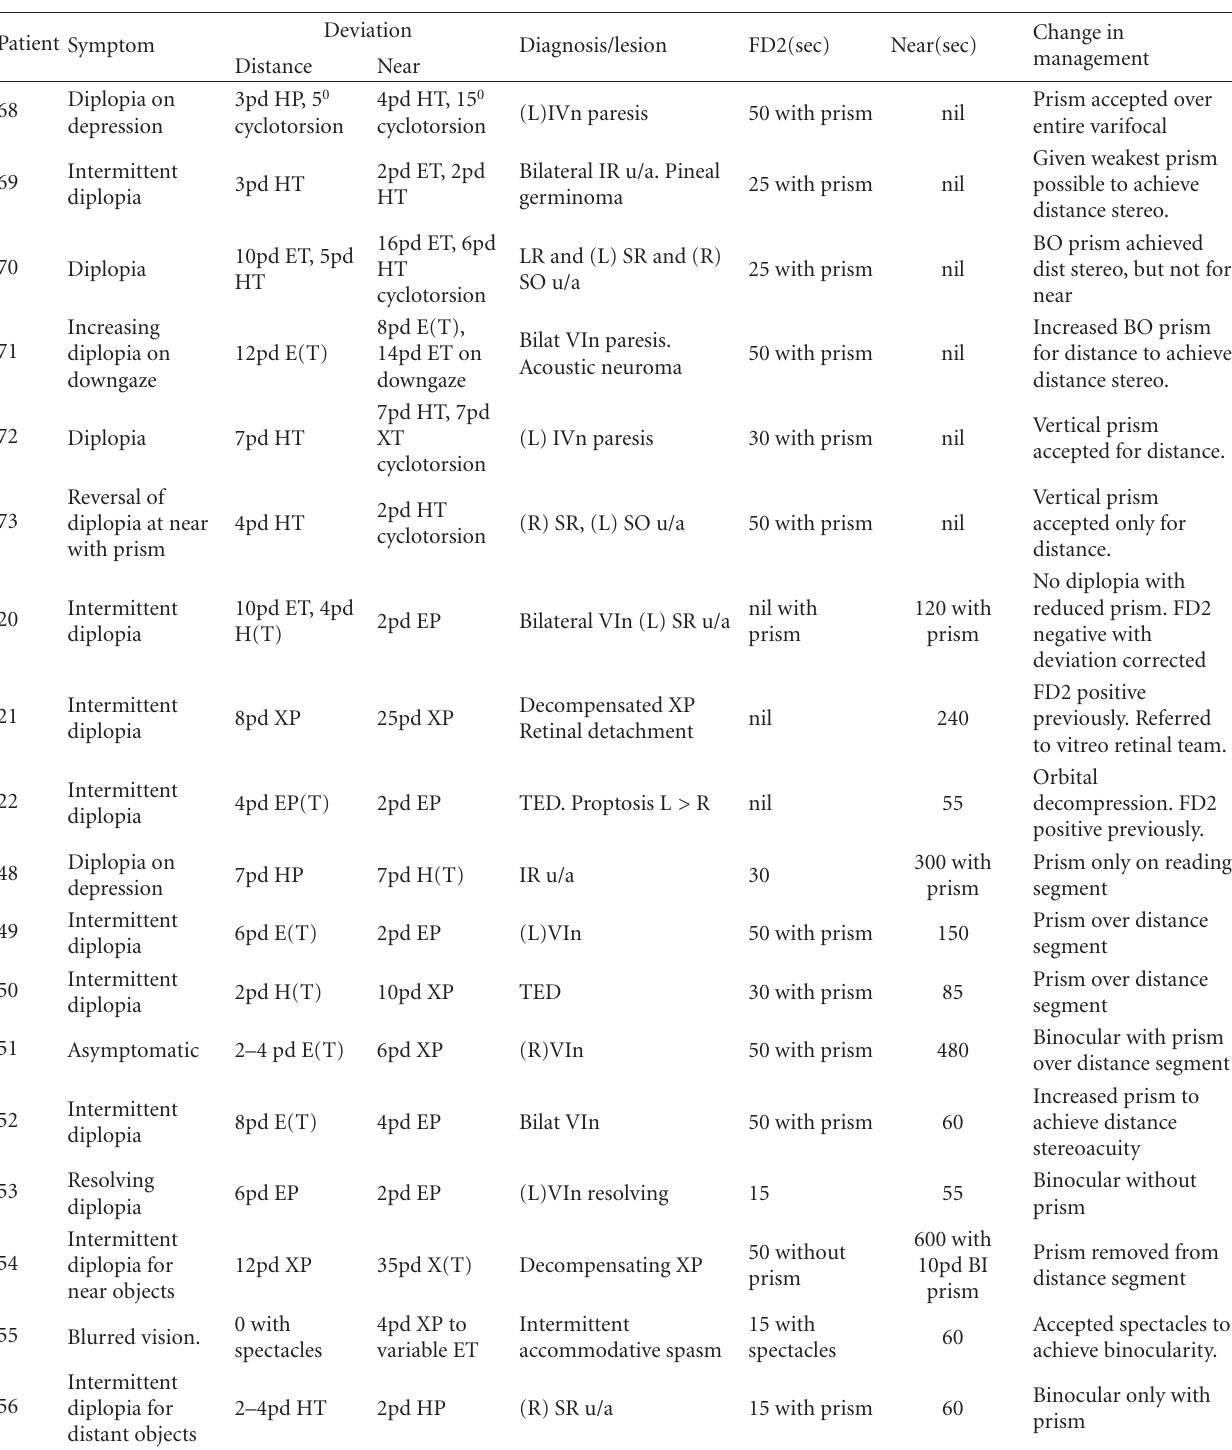
Table 2: Patients who had a change in clinical management following introduction of FD2. Patients 68–73 had evidence of stereopsis using the FD2 but not with near tests, patients 20–22, stereopsis with the near tests but not FD2 and patients 48–61 evidence of stereopsis with both the FD2 and near tests, respectively. Patient 21 was excluded from further analysis as the change was due to retinal detachment. Summary of the change in management is included in the right-most column. Diagnosis is included where established. Where no specific diagnosis established, extraocular muscle deviation recorded. Prism dioptres (pd), intermittent heterotropia (T), esophoria (EP), esotropia (ET), hyper or hypotropia (HT), hyper or hypophoria (HP), base-out (BO), and base-in (BI) prism, lateral rectus (LR), superior rectus (SR),